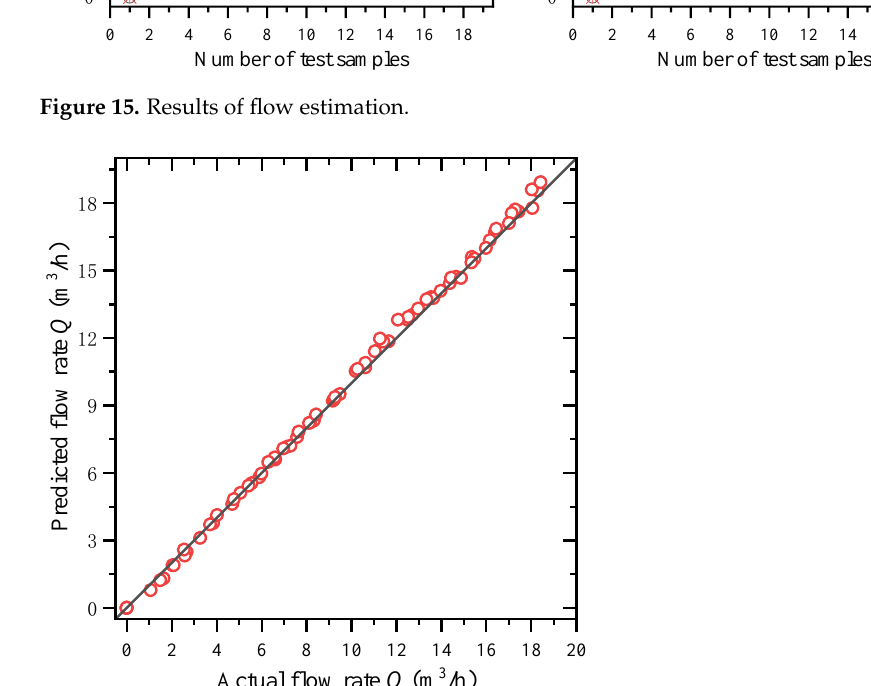
Figure 16. Comparison of predicted and actual flow rates.